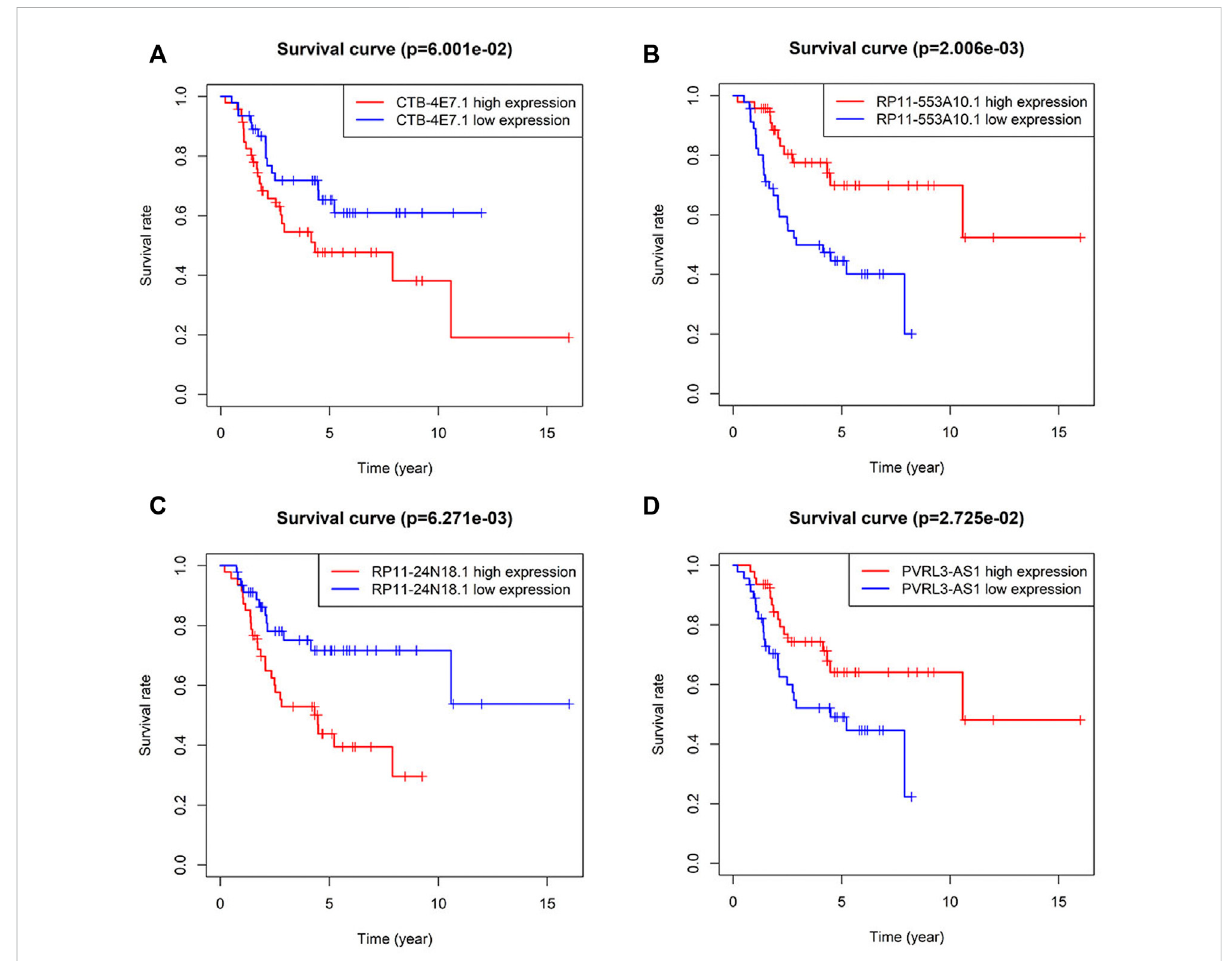
FIGURE 2 Kaplan – Meier curves for survival of osteosarcoma patients strati fi ed by the four lncRNAs. (A) CTB-4E7.1; (B) RP11-553A10.1; (C) RP11-24N18.1; and (D)